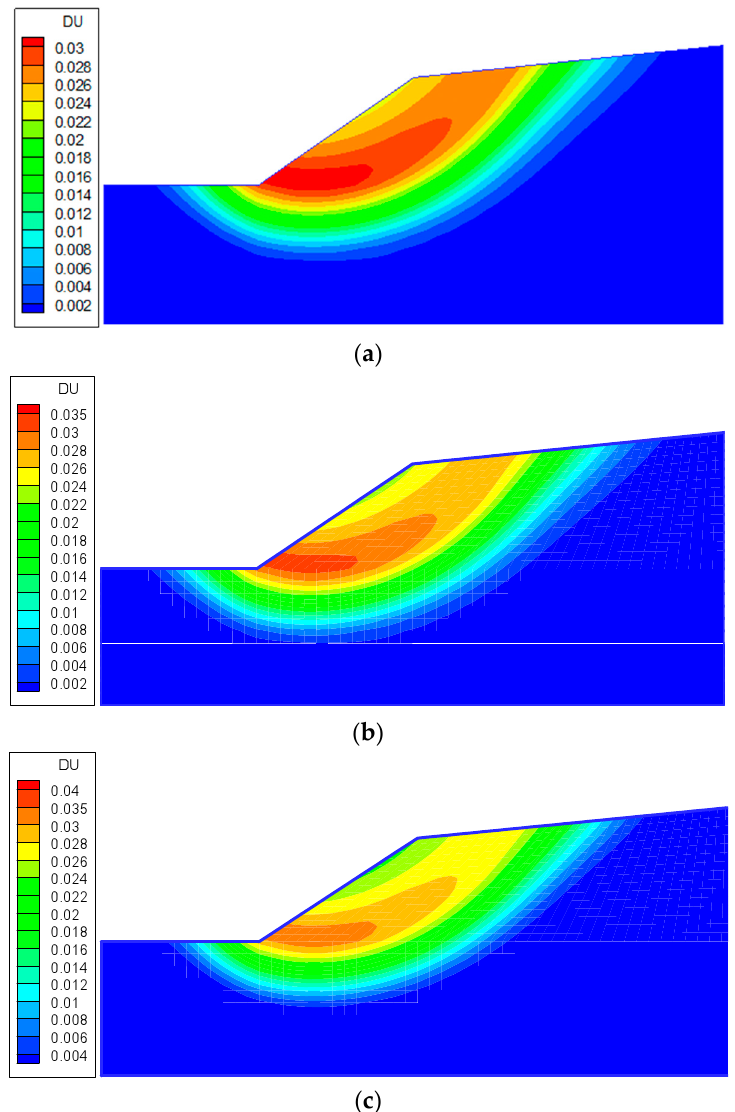
Figure 13. Contours of the displacement increment in Case 1. ( a ) Case 1-1. ( b ) Case 1-2. ( c ) Case 1-3.